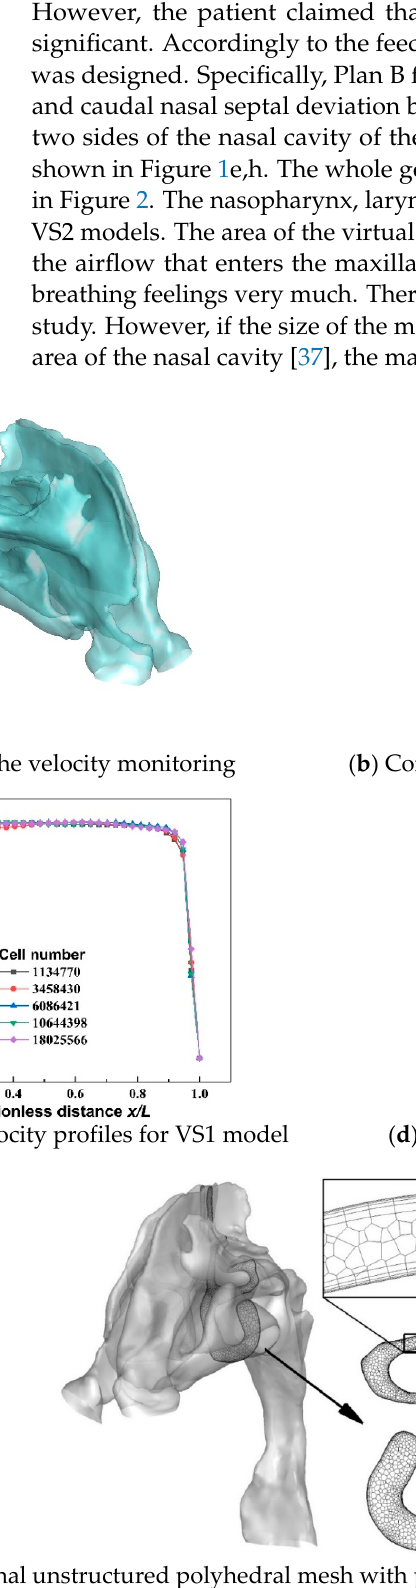
Figure 2. Mesh independence tests and mesh structure.